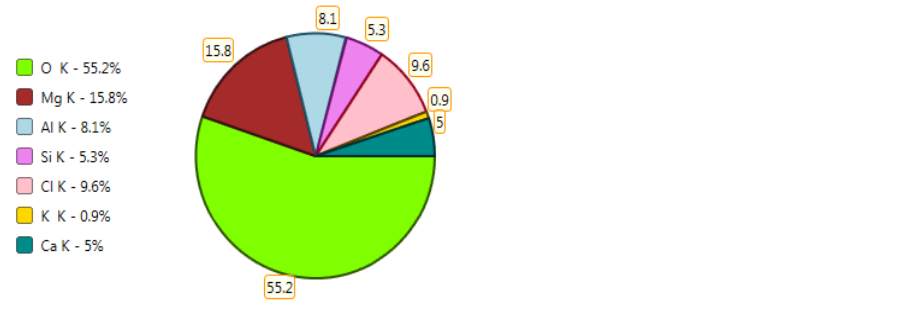
Figure 24. X-ray microanalysis (EDS) in point 1, percentage by mass of ingredients of the mineral.